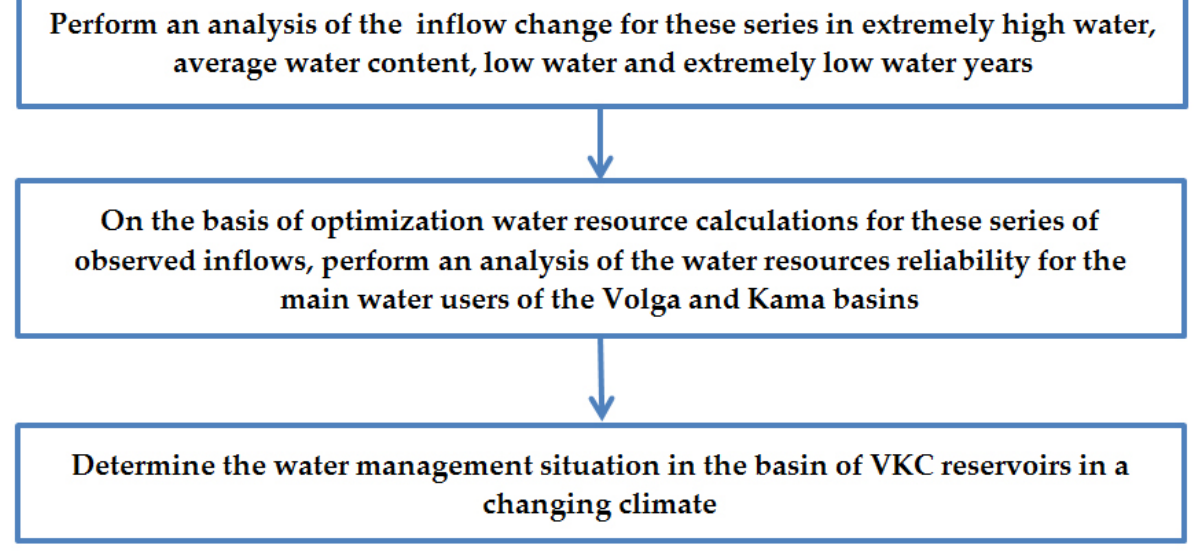
Figure 2. The flowchart of the problems solved in the course of the research.